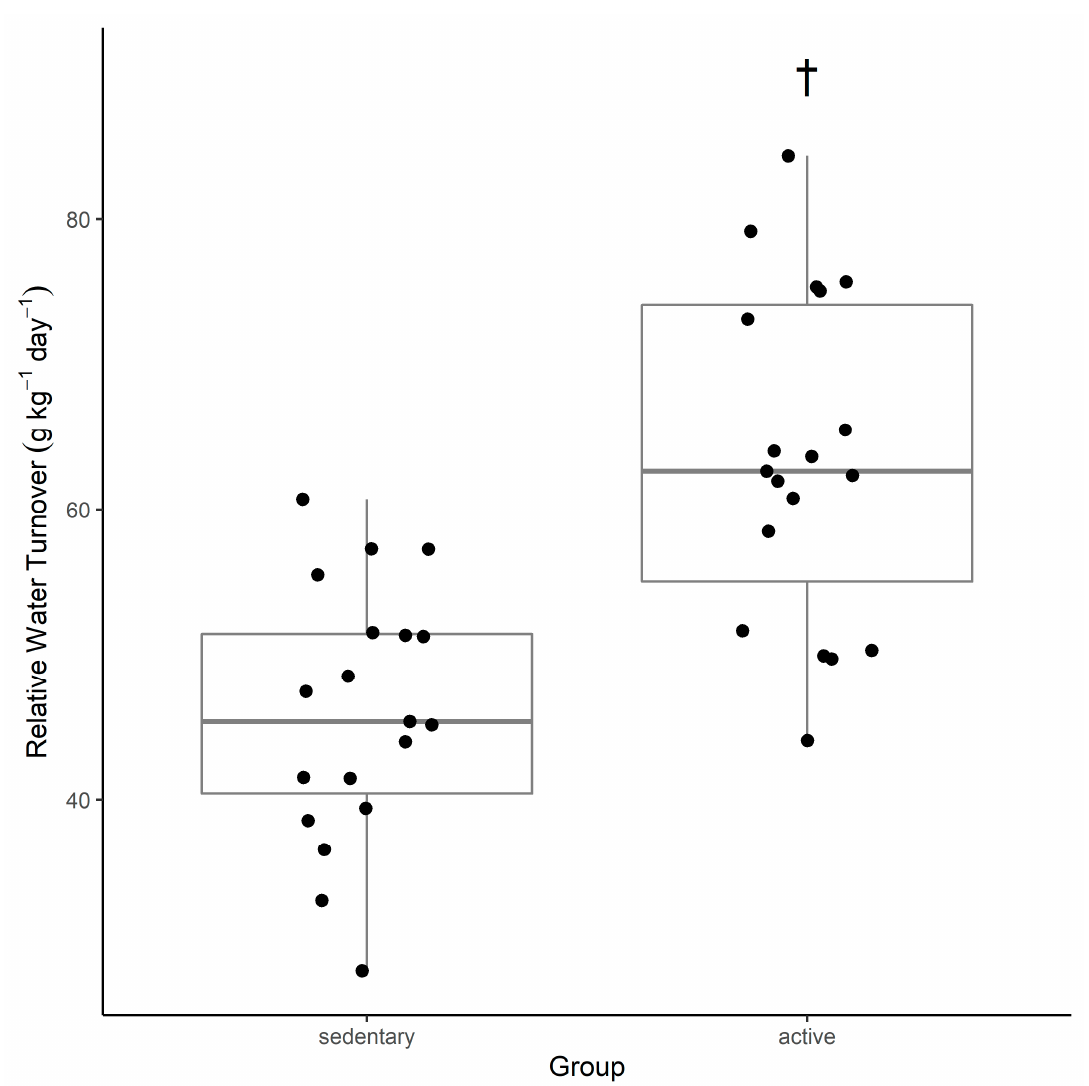
Figure 1. Relative water turnover of active and sedentary participants. † indicates statistical evidence for a difference between groups.